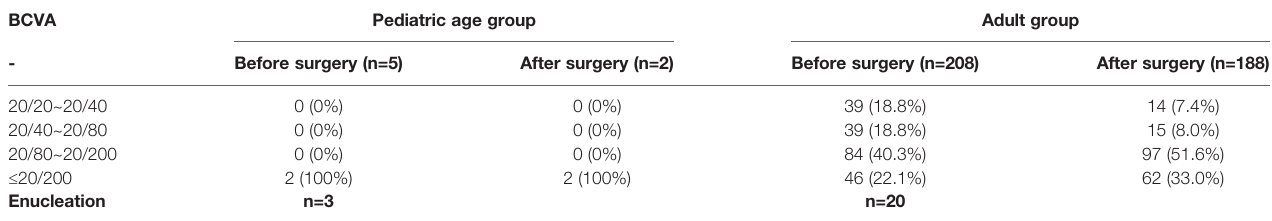
TABLE 3B | BCVA of 213 UM patients before and after surgery of PTSU and